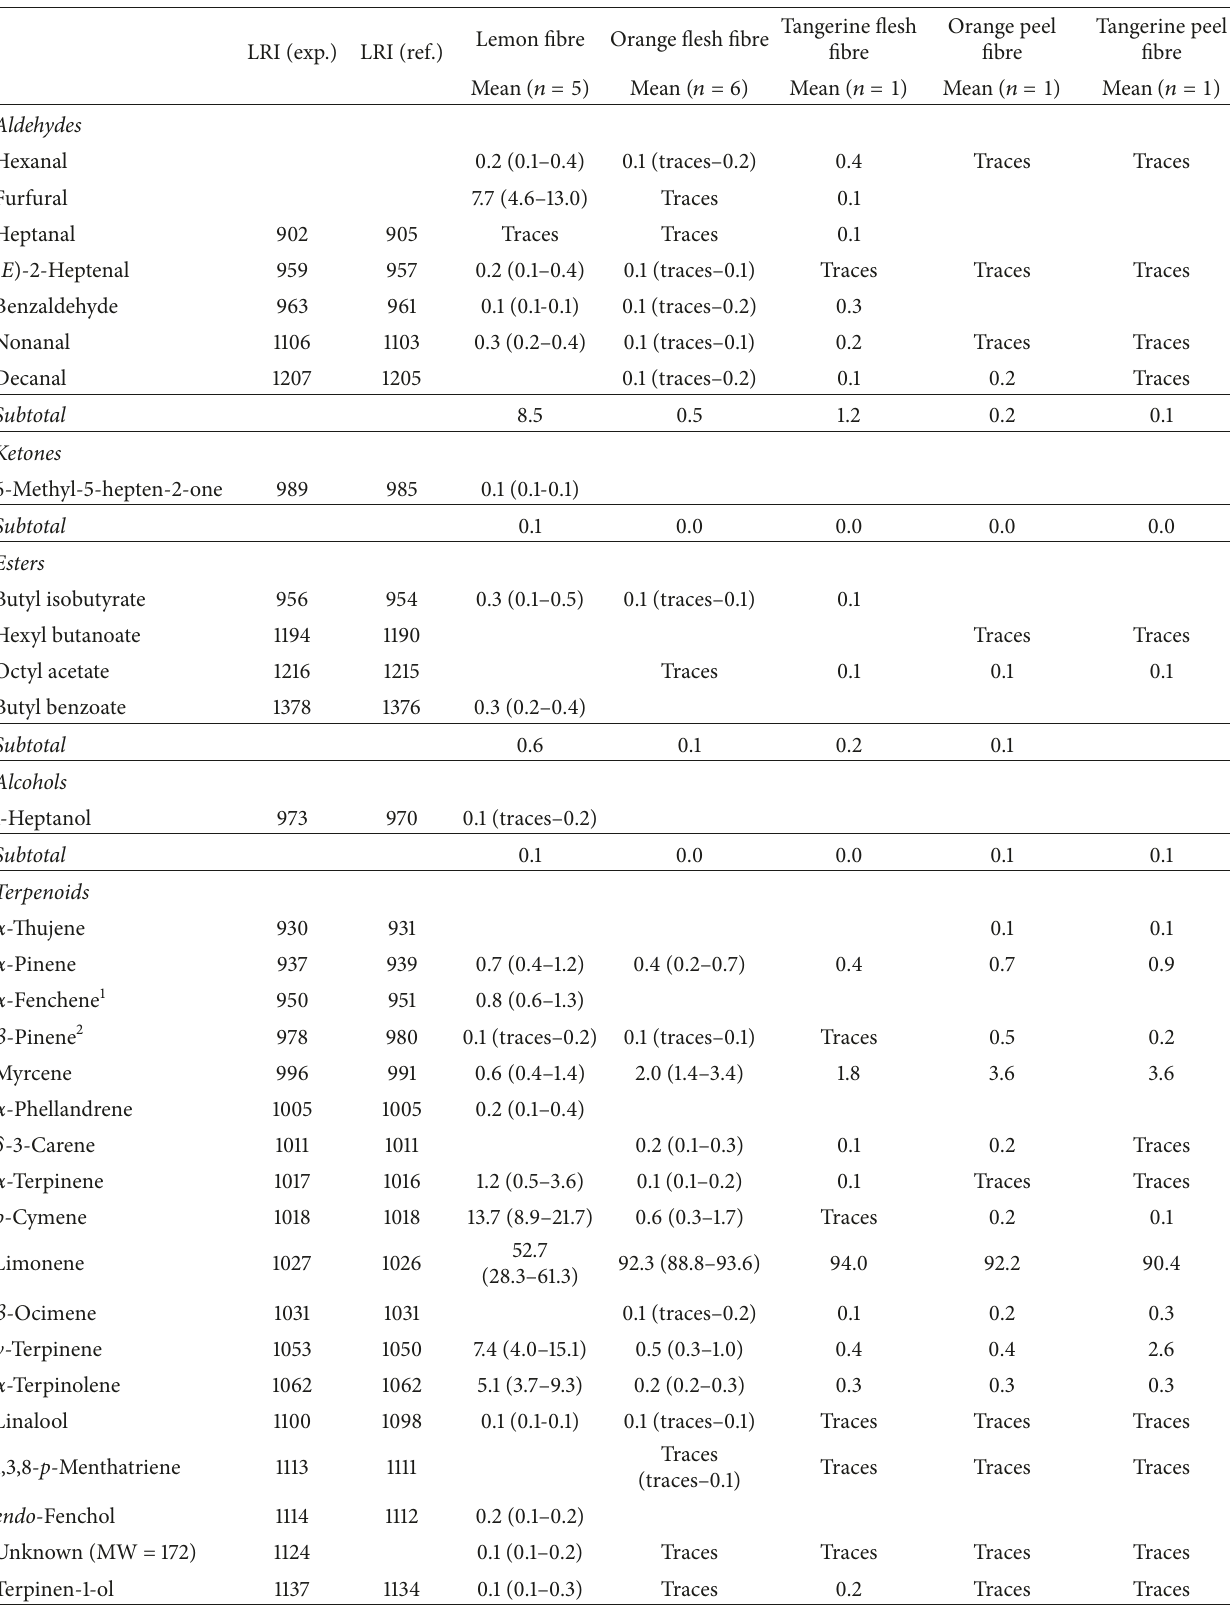
Table 1: Average relative percentage of volatile contents and their distribution ranges in different production batches (in parenthesis) of citrus fibres, as determined by HS-SPME-GC-MS